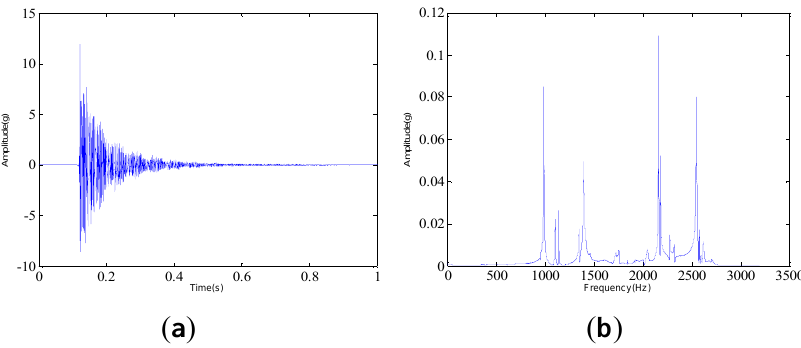
Figure 17. The measured vibration signal of the aero-engine rotor in case 2 and the corresponding frequency spectrum. ( a ) vibration signal; ( b ) frequency spectrum.